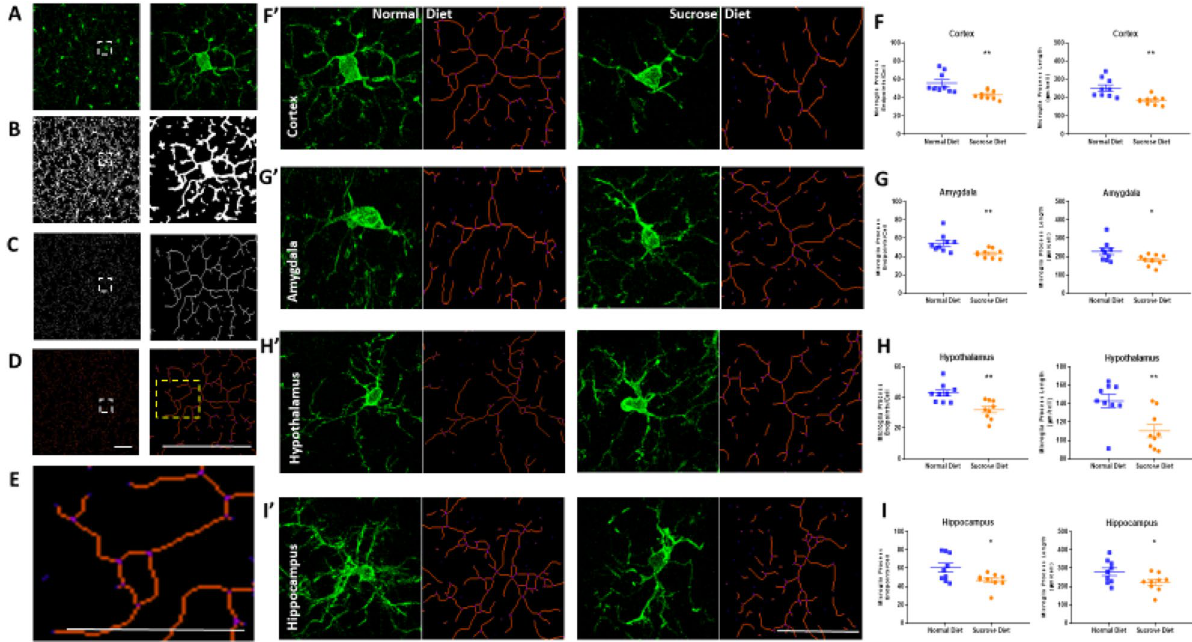
Figure 5. Analysis of microglial morphology following 12-week binge sucrose intake in rats. Microglial morphology was analysed in Fiji software using the ‘Analyse Skeleton’ plugin. ( A – D left panel) shows the process to prepare photomicrographs for skeleton analysis using a series of plugin protocols, scale bar = 50 µm. ( A – D right panel) shows a magnified version of the white dotted box in ( A – D ) left panel, scale bar = 50 µm. ( E ) Magnified version of yellow dotted box in D right panel showing tag skeletonized processes as orange, endpoints as blue, and junctions as purple, scale bar = 25 µm. ( F’ – I’ ) Representative skeletonized image and original photomicrograph of a single IBA-1 positive cell showing the relationship between skeleton and photomicrograph in a normal diet and a sucrose diet rat ( F’ ) motor cortex, ( G’ ) amygdala, ( H’ ) hypothalamus and ( I’ ) hippocampus. Quantification of microglial ramification was performed on entire photomicrographs (not single cells), which showed reduced endpoints/cell and process length/cell respectively in sucrose rat ( F’ ) motor cortex, ( G’ ) amygdala, ( H’ ) hypothalamus and ( I’ ) hippocampus, scale bar = 50 µm. All values are presented as number of microglial endpoints/cell ± SEM or total process length/cell ± SEM in the brain region imaged and analysed with Student’s two-tailed t-test. *p < 0.05, **p < 0.01 compared to controls. All values presented are from n = 9 per Long-term sucrose diet-associated microgliosis is accompanied by morphological alterations in microglial ramification. Microglial morphology is a reliable indicator of microglial activation; normal resting microglia have ramified processes, while activated microglia in altered physiological states, diseases and inflammation have reduced ramifications 21,22 . To quantify the observed decreased in microglial ramification in the sucrose group rats, we measured microglial endpoints and total branch length from entire photomicrograph fields (not individual cells) from different brain regions. We normalized the results to the number of Iba-1 posi- tive microglial cell somata to calculate the number of microglia endpoints/cell and microglia process length/cell. Our analysis indicated that microglial ramifications were significantly lower in the sucrose group rats as demonstrated by branch endpoints/cell in the motor cortex (56.0 ± 3.6 vs 42.9 ± 1.5, Cohen’s d = 1.54, **p = 0.004, Fig. 5F), amygdala (54.6 ± 3.2 vs 43.5 ± 1.6, Cohen’s d = 1.43, **p = 0.007, Fig. 5G), hypothalamus (42.9 ± 2.0 vs